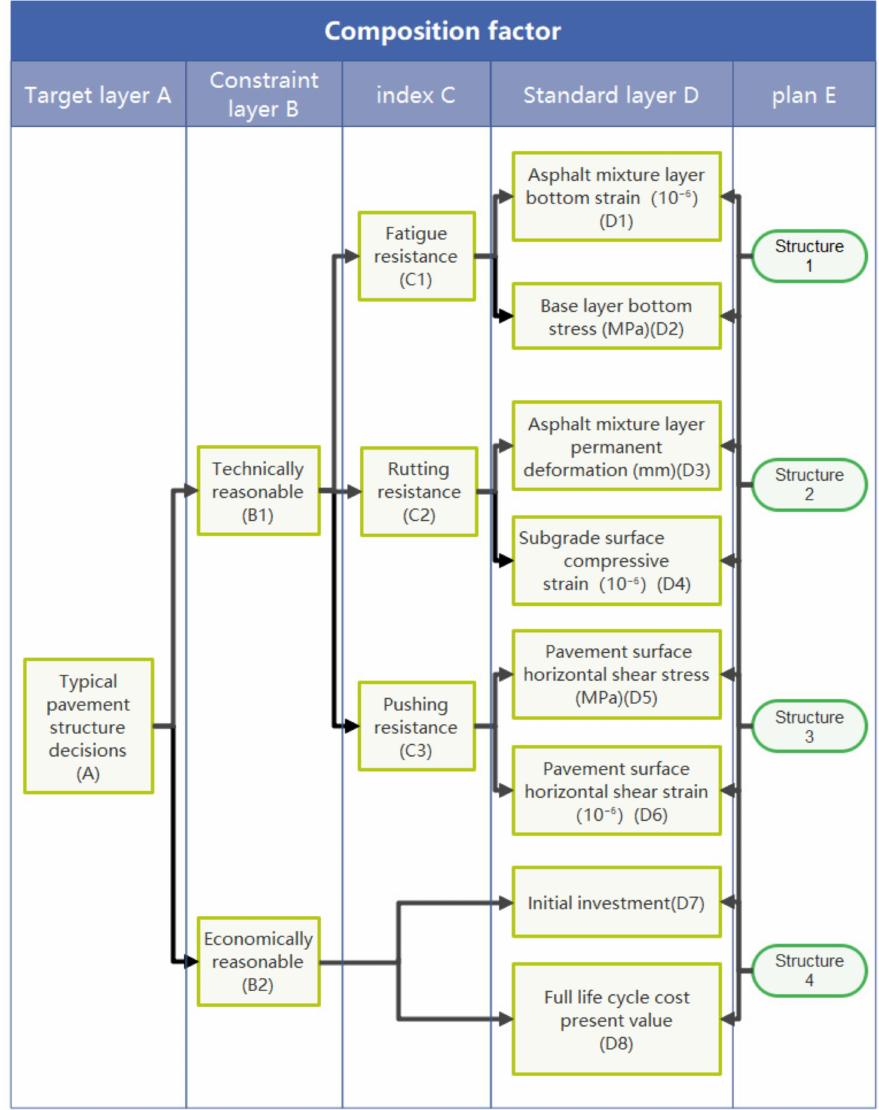
Figure 3. Evaluation index system for typical optimal pavement